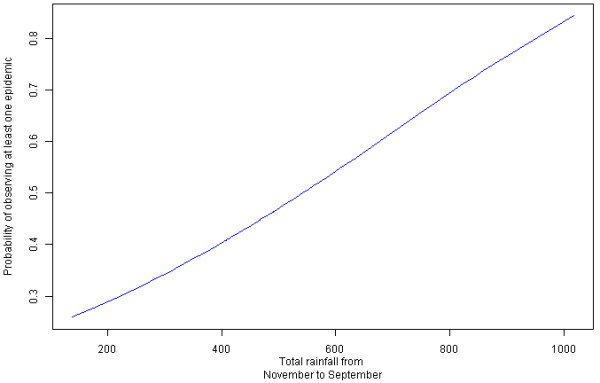
Theoretical probability of observing at least one epidemic according to the total amount of precipitation. The generalized linear model with a Poisson error distribution was used to compute the fitted probabilities. The fitted values are plotted against the amounts of precipitation (from previous November to current September). The more it rains in the previous winter, current spring and summer, the more probable epidemics occur.